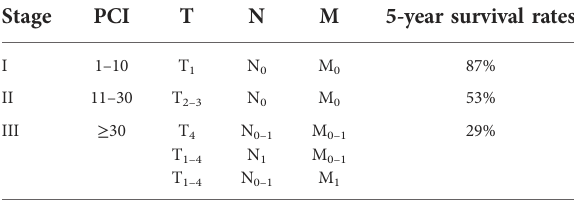
TABLE 1 TNM staging system for diffuse malignant peritoneal mesothelioma